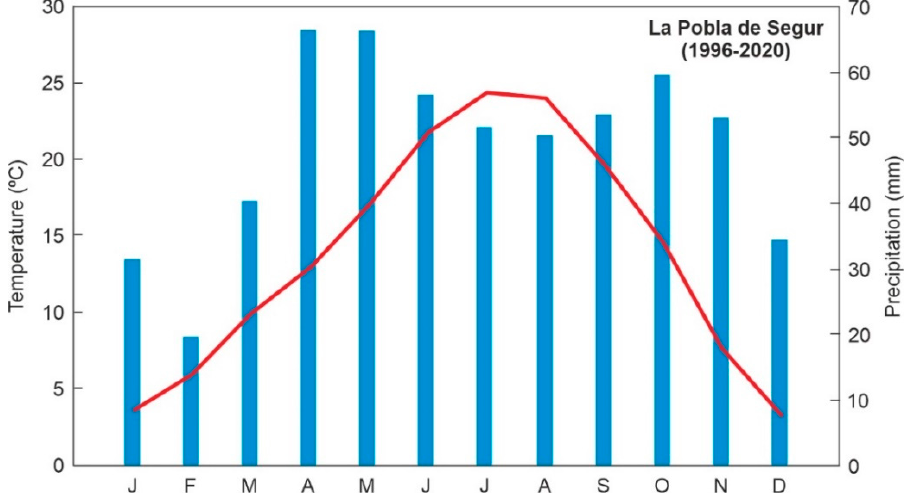
Figure 2. Climatic diagram of the La Pobla de Segur weather station for the period 1996–2020, according to the Catalan Meteorological Service (https://www.meteo.cat/; accessed on 14 April 2022). Average monthly temperature is represented by a red line, and average monthly precipitation is represented by blue bars.